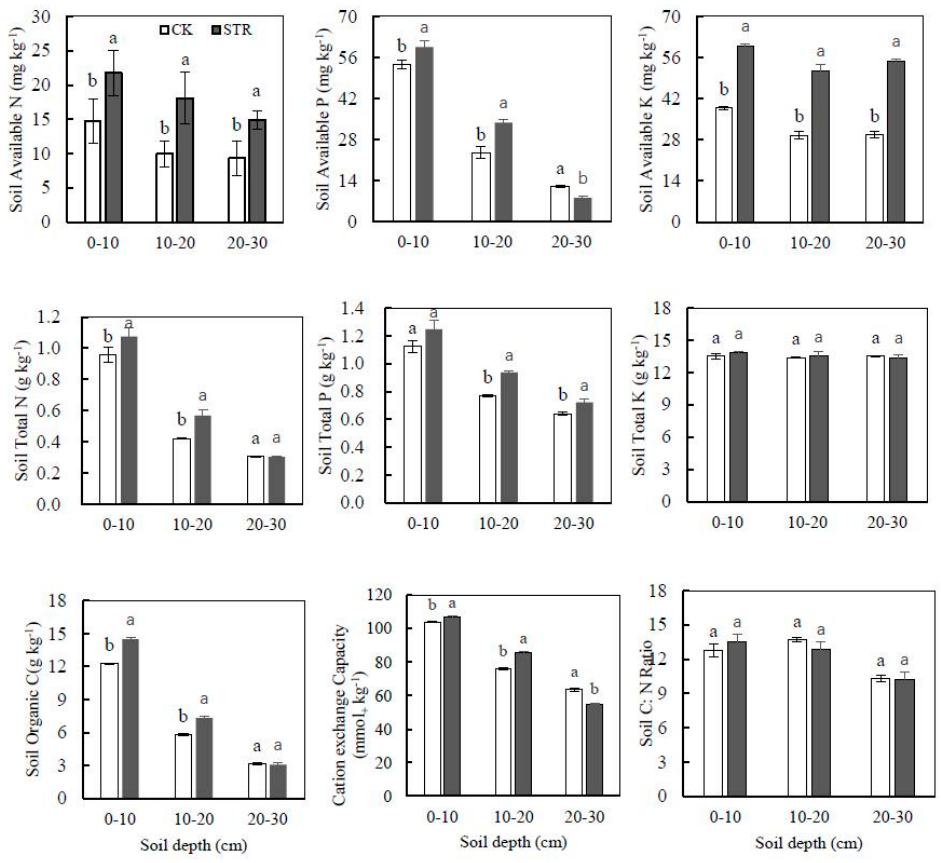
Figure 2. The nutrient status of the soil samples collected in October 2016 as affected by straw incorporation (STR) and straw removal (CK). Different letters above columns for the same soil depth indicate a significant difference ( p < 0.05).